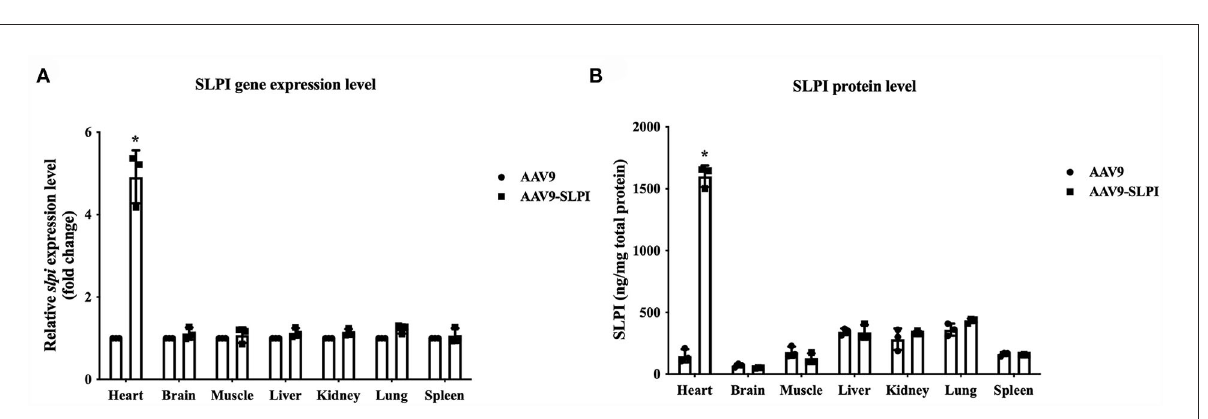
FIGURE2 Determination of slpi gene (A) and protein expression level (B) in organs of I/R injury rats treated with viral particles (* p < 0.05 vs. AAV9).